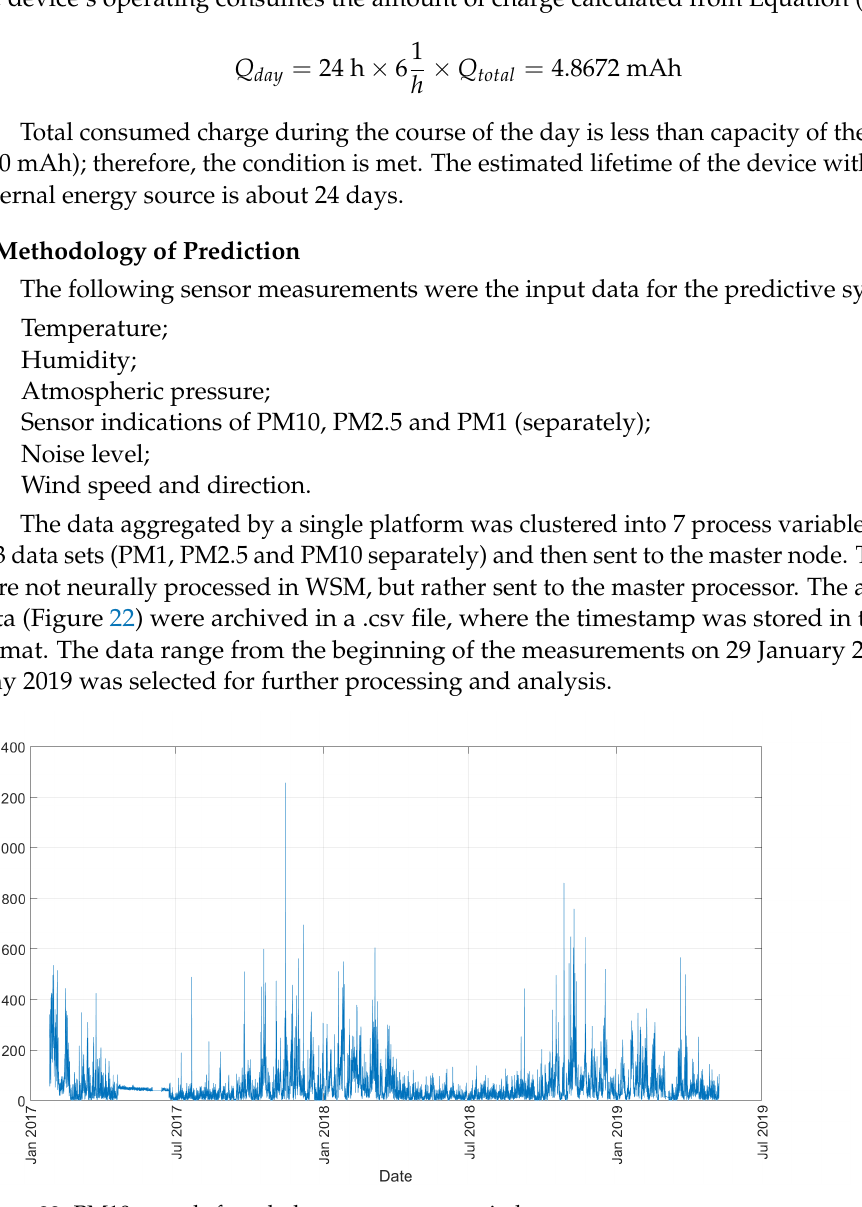
Figure 22. PM10 records for whole measurement